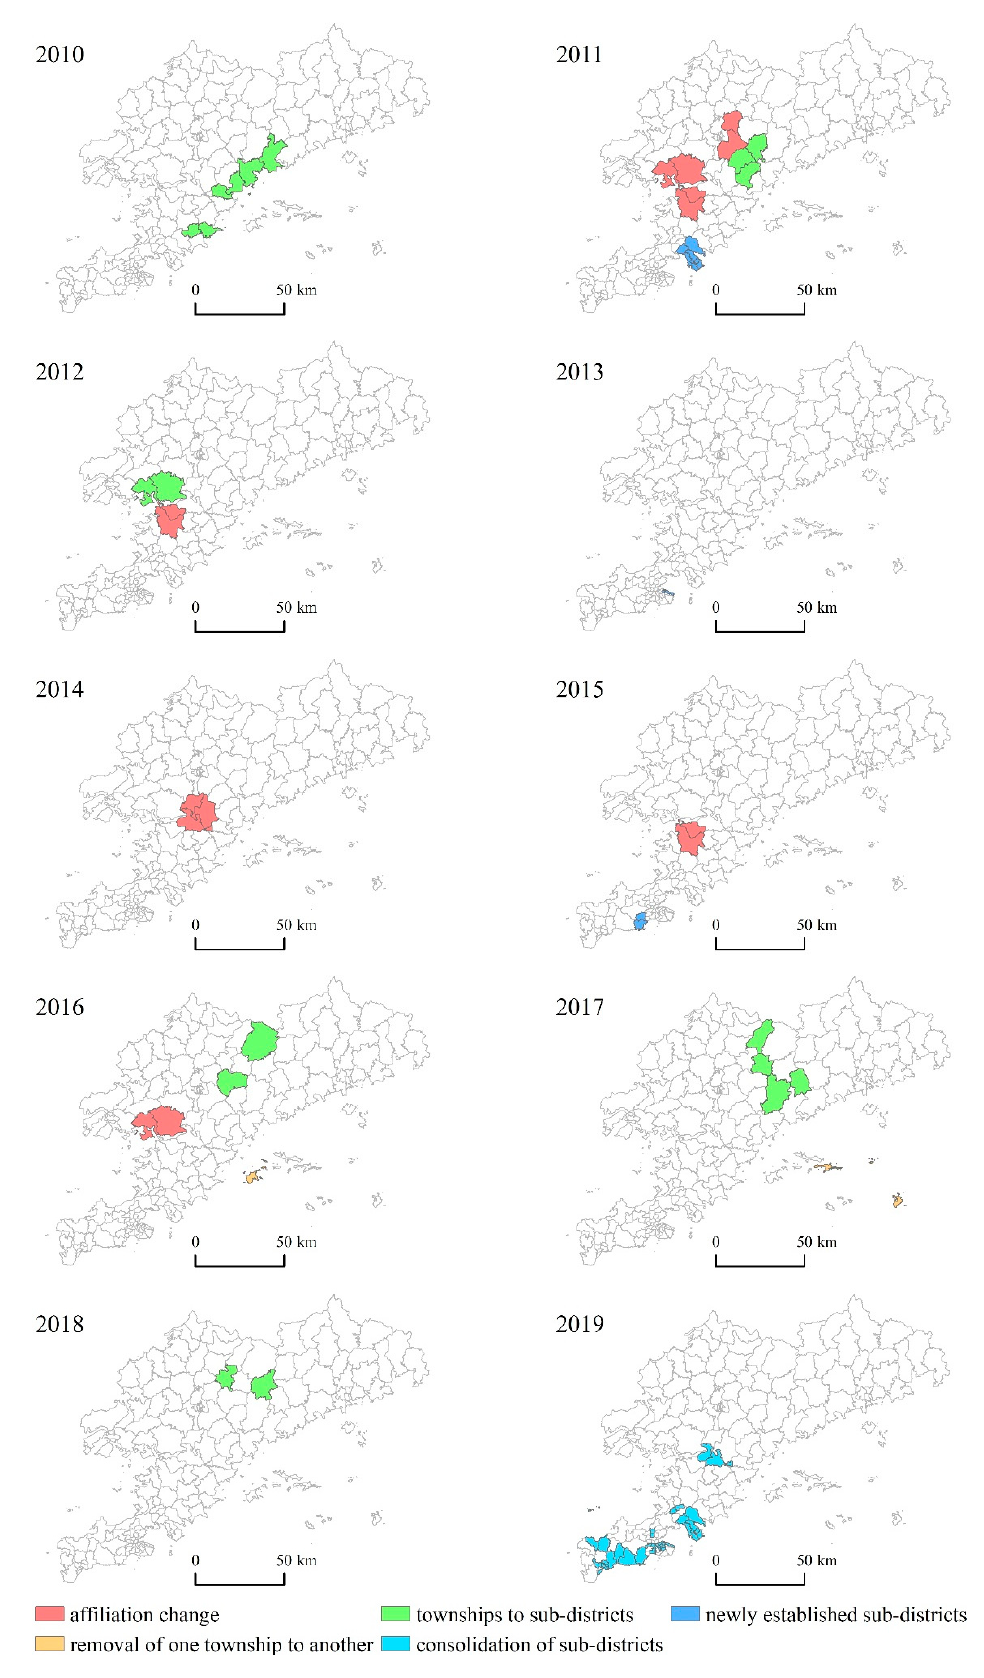
Figure 2. Adjustment of administrative divisions of townships in Dalian from 2010 to 2020.